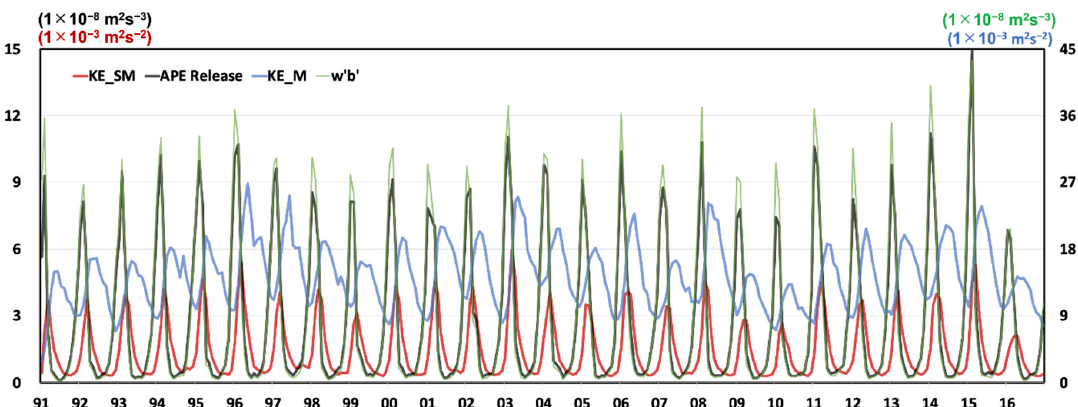
Figure 5. Monthly time series of submesoscale KE (KE_SM, red curve), the parameterized available potential energy (APE) release (black curve), mesoscale KE (KE_M, blue curve), and the direct estimation ( = w’b’, green curve) averaged within the mixed-layer depth (MLD) in the STCC region. The left vertical axis shows the scales of the KE_SM and the parameterized APE release and the right vertical axis shows the scales of the KE_M and w’b’. The factor three between the scales on the left and right vertical axes emphasized that the parameterized APE release is three times smaller than the APE release directly estimated from OFES2_NP30 outputs.